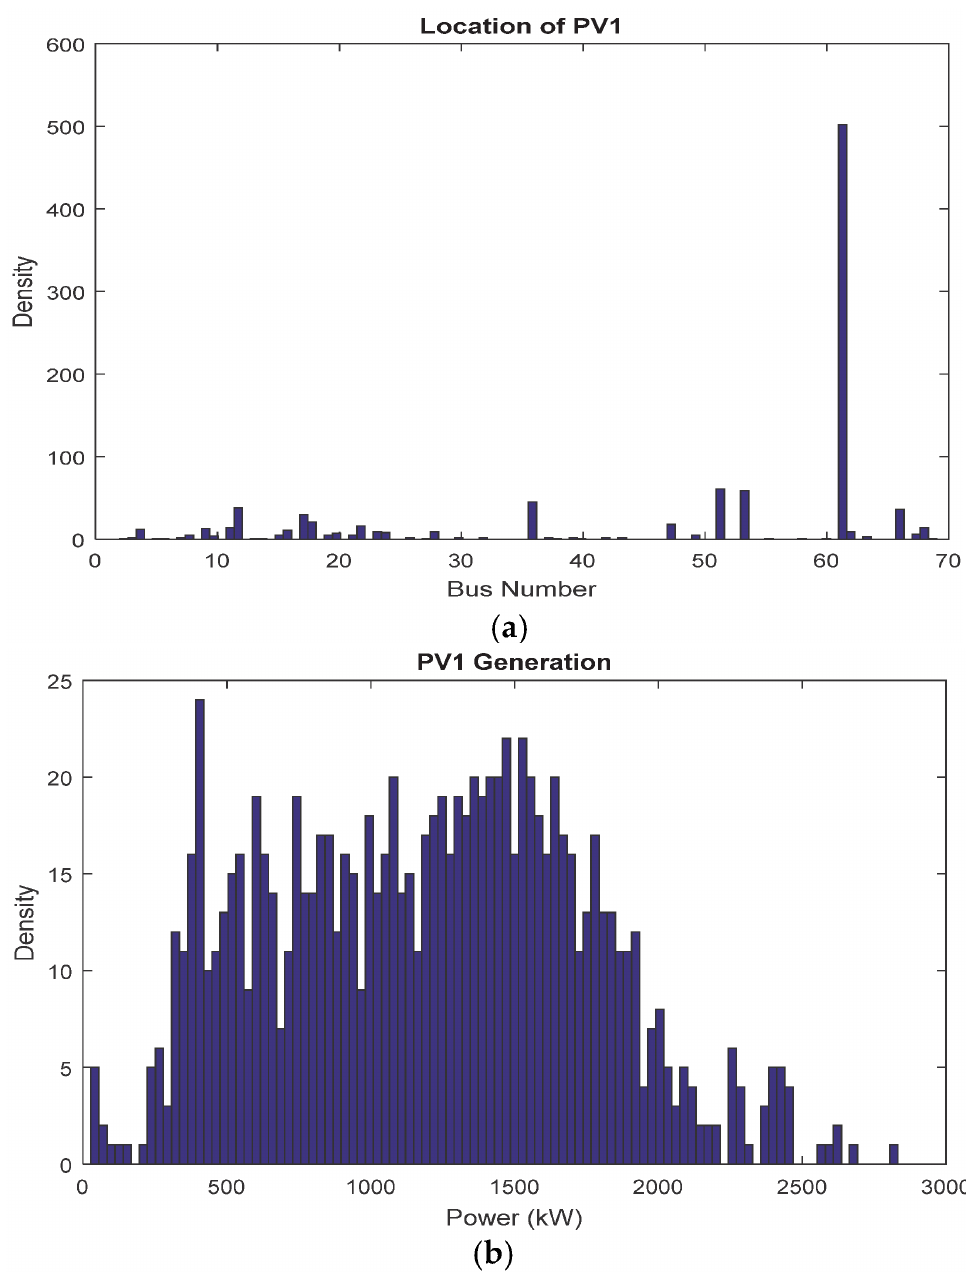
Figure 15. The PDF of placement and size of 1st PV in the 69-bus system with uncertainties using IHLOA: ( a ) location of 1st PV; ( b ) 1st PV